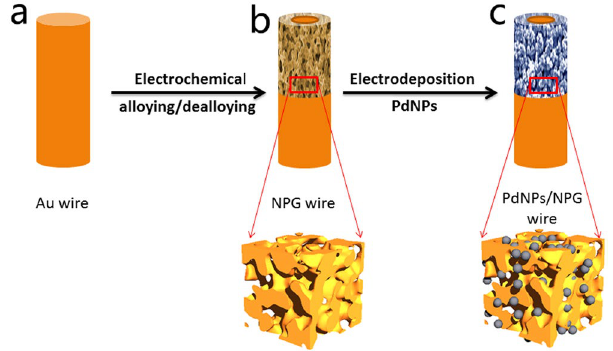
Figure 1. Schematic diagram for the fabrication of the biosensor. ( a ) Au wire. ( b ) 3D bicontinuous nanoporous gold wire fabricated by electrochemical alloying/dealloying. ( c ) Pd decorated NPG